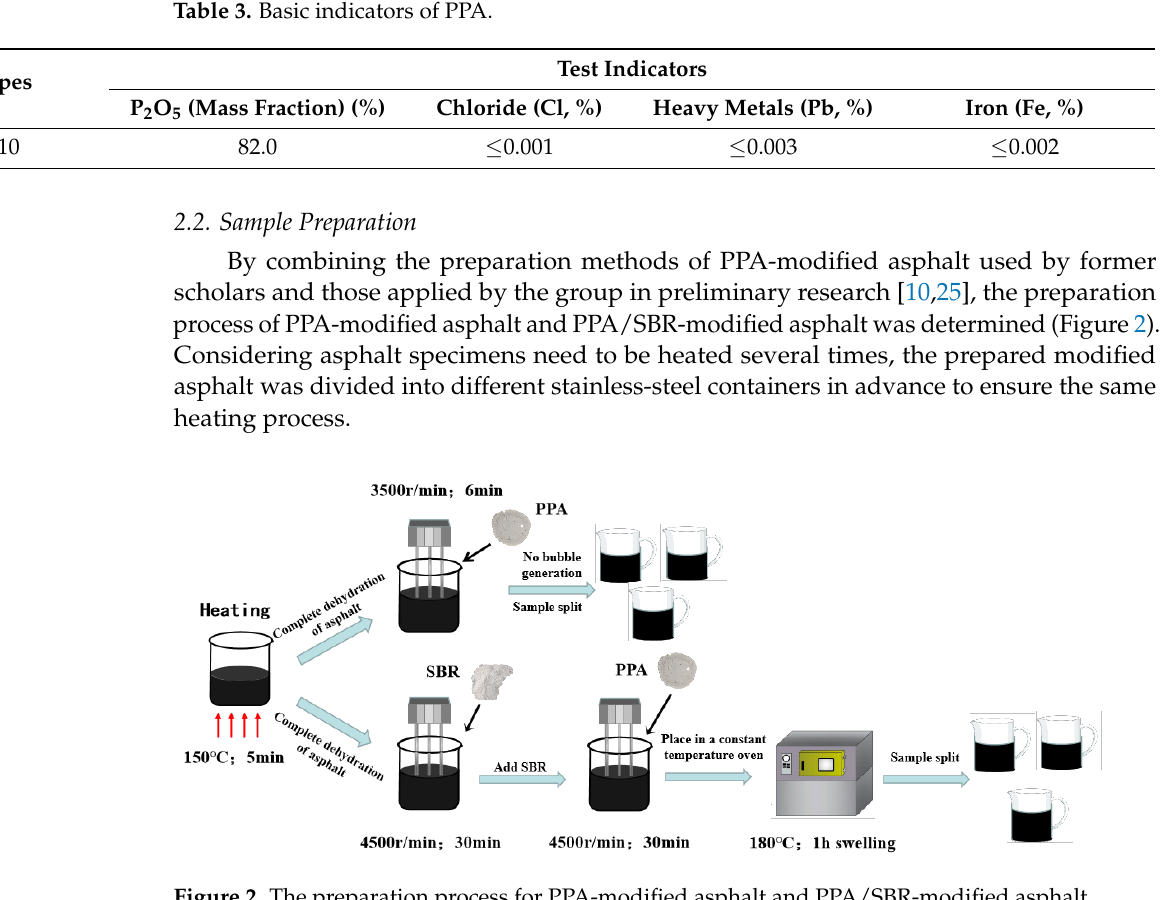
Figure 2. The preparation process for PPA-modified asphalt and PPA/SBR-modified asphalt.